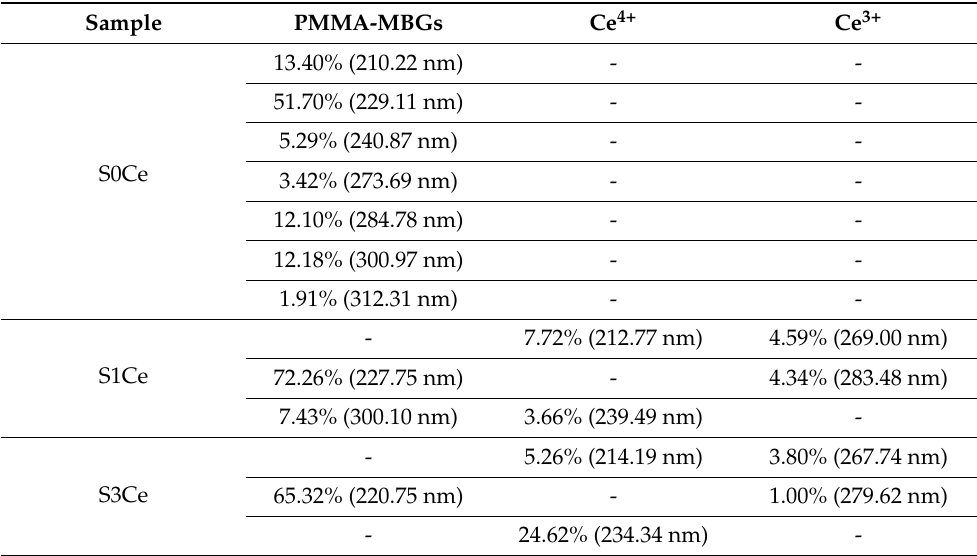
Figure 4. The curve fitting of the cerium (Ce 4+ /Ce 3+ ) absorption band in PMMA-MBGs composite scaffolds: ( a ) S0Ce composite scaffold; ( b ) S1Ce composite scaffold; ( c ) S3Ce composite scaffold. Table 1. Percentage of Ce 4+ /Ce 3+ in PMMA-MBGs composite scaffolds calculated from the fitting of Gaussians in the UV region, with the corresponding positions indicated in parentheses.